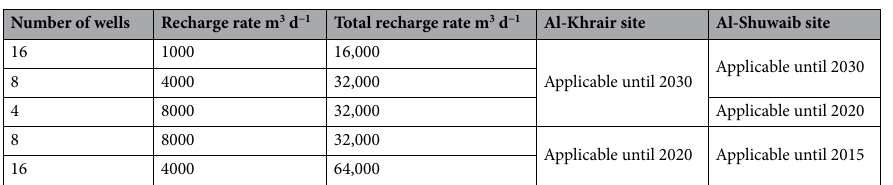
Table 4. Summary of recharge rates with possible implementation options in the sites.